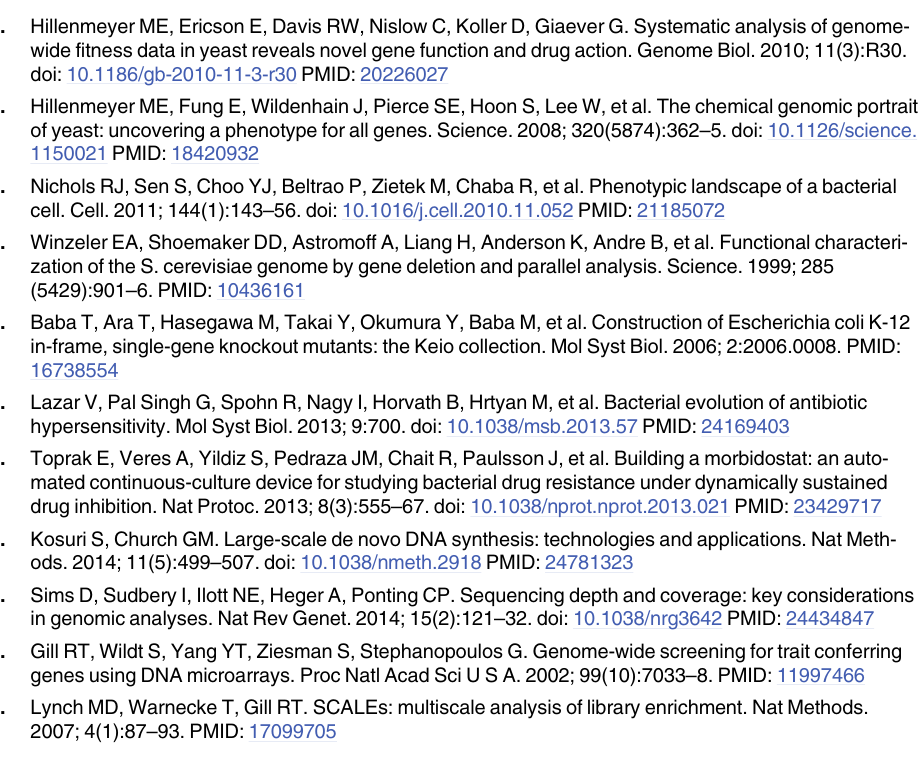
S2 Table. Top 10 highly enriched alleles in OD selections for each antibiotic. S3 Table. Top 10 diminished alleles in OD selections for each antibiotic. S4 Table. Nonparametric ANOSIM values for important categories in this study. The R sta- tistic represents the how different the tested categories are, with a value near zero indicating no significant difference between the groups, and a value near 1 indicating difference. S5 Table. A1 top genes used for classification between the eight